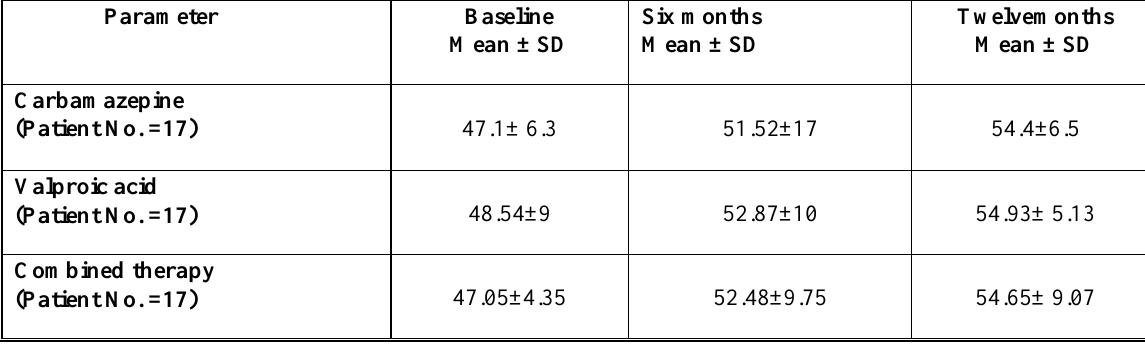
Table 2. Waist circumference of children after treatment with Carbamazepine, Valproic acid and combined